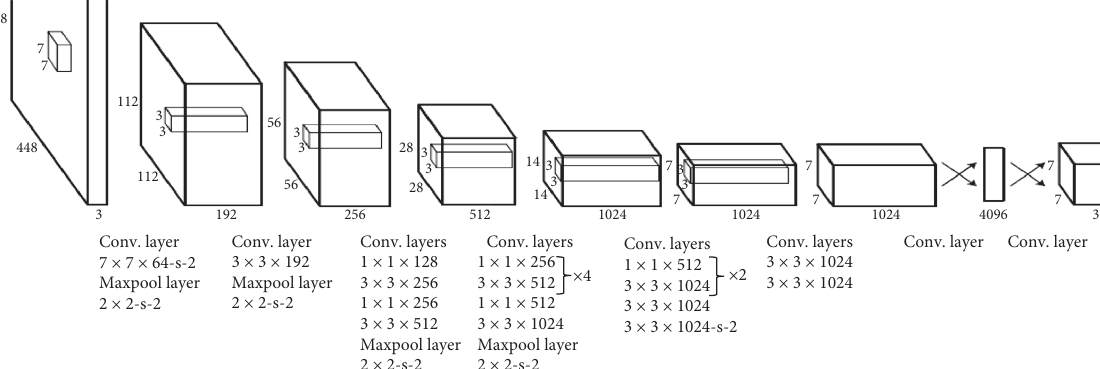
Figure 3: YOLO network architecture (from [31]).